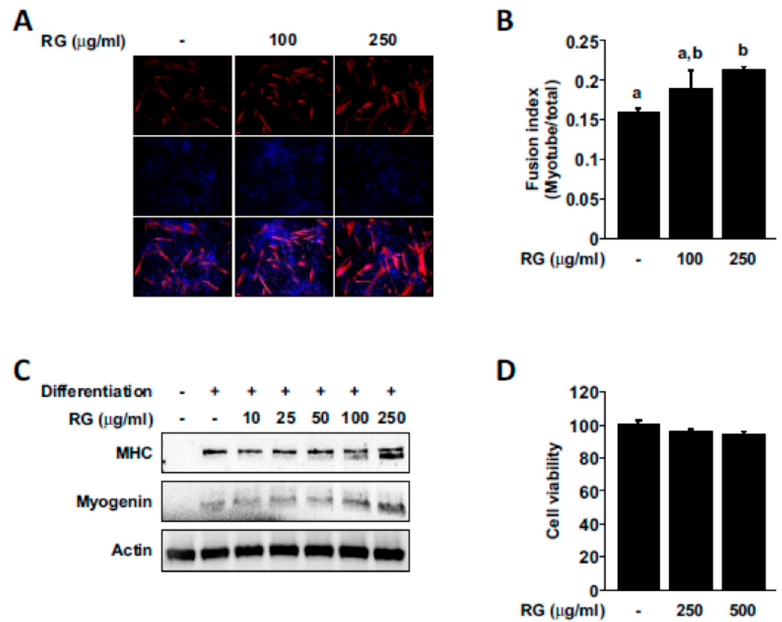
Figure 6. Effects of RG on myogenic differentiation. Cells were induced to differentiate for 2 days, and then cells were treated with the indicated dose of RG for 48 h. ( A ) To evaluate myotube formation, cells were stained for myosin heavy chain (MHC) (red). Nuclei were stained with DAPI (blue). ( B ) Fusion index was determined (number of nuclei within MHC-stained myotubes/total nuclei) ( C ) Protein extracts were analyzed for the levels of MHC, myogenin, and beta-actin using immunoblot analysis. ( D ) Cell viability was measured by MTS assay. Bars with different letters mean significant differences from each other (* p < 0.05).